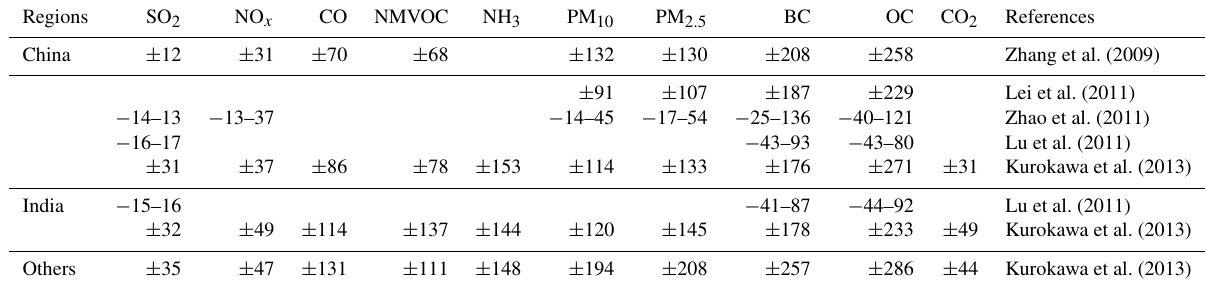
Table 9. Uncertainty in emission estimates by Asian regions in 2010 (95% confidence intervals; unit: %).